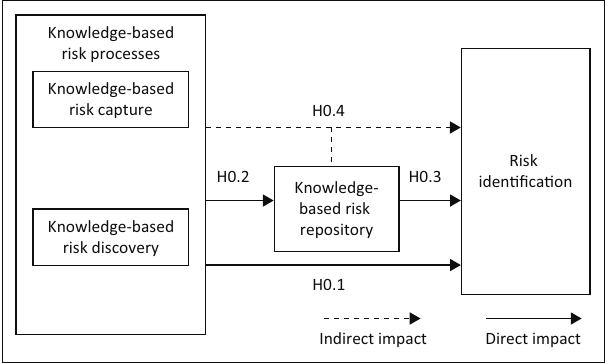
FIGURE 1: Model of the impact of knowledge-based risk process on knowledge- based risk repository and risk